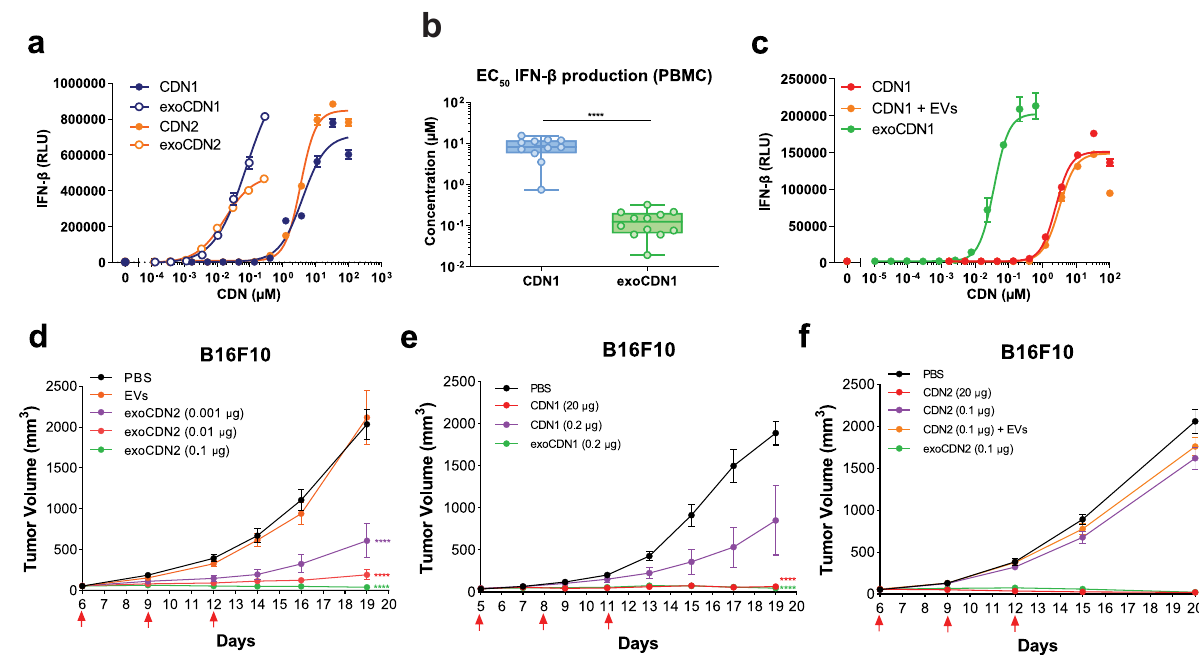
Fig. 1 exoSTING enhances the potency of a CDN in in vitro and in vivo. a Representative dose-response curves of IFN- β production in human PMBC supernatant after treating with two different CDN-loaded EVs, exoCDN1 and exoCDN2, compared with free CDNs ( n = 2 biological replicates per donor). Biological replicates (three healthy donors) are presented in Supplementary Fig. 2b. b EC 50 value of IFN- β production in human PBMC after treating with free CDN1 and exoCDN1 ( n = 12 healthy donors). c Representative dose-response curves ( n = 3 healthy donors) of IFN- β production in PBMC after treating with free CDN1, free CDN1 with EVs, and exoCDN1 ( n = 2 biological replicates per donor). **** P < 0.0001 by unpaired t -test. d – f C57BL/6 mice were implanted subcutaneously with 1 × 10 6 B16F10 cell on right fl ank of mice. Additional implantation of tumors is speci fi ed in each legend. When tumor volumes reached 50 – 100 mm 3 , testing agents were injected intratumorally three times with 3 days interval. Red arrows in the graph indicate IT injection days. Tumor growth were measured over time ( n = 5 animals per group). CDN1 MR SS-2 CDA, CDN2 cAIM(PS)2 Di fl uor (Rp/Sp), RLU relative luminescent unit. Data are presented as means ± s.e.m from replicate samples as indicated. **** P < 0.0001 by two-way ANOVA with Tukey ’ s multiple comparison test for tumor growth